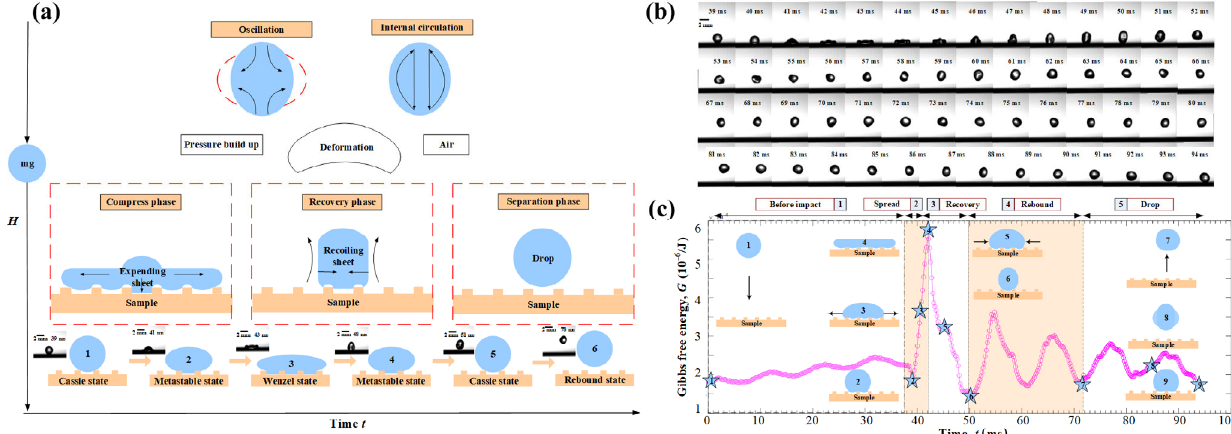
Fig. 5 Theoretical model and experimental impact images of droplet morphology change during droplet impact and experimental data showing change in Gibbs free energy of droplet with time. (a) Process diagram showing drop before and after impacting dragonfly wing surface. (b) Impact phase image of drop on dragonfly wing surface during the first rebound. (c) Drop shape evolution vs. time of drop impacting dragonfly wing surface from Stage 1 (before impact) to Stage 5 (drop) during Rebound